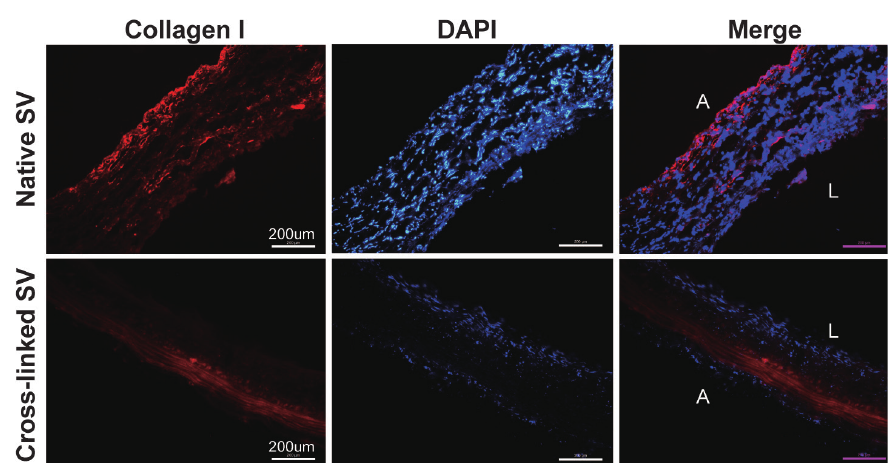
Fig. 1 - Collagen I immunofluorescent staining of frozen section. The degree of cross-linking was identified by comparing with different immunofluorescent images (magnification, ×200). A=abluminal surface; DAPI=4’,6-diamidino-2-phenylindole; L=luminal surface; SV=saphenous vein